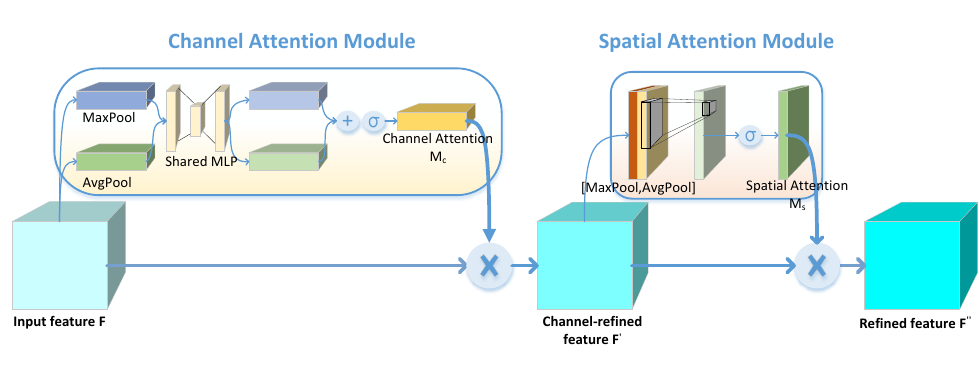
Figure 2. CBAM structures.